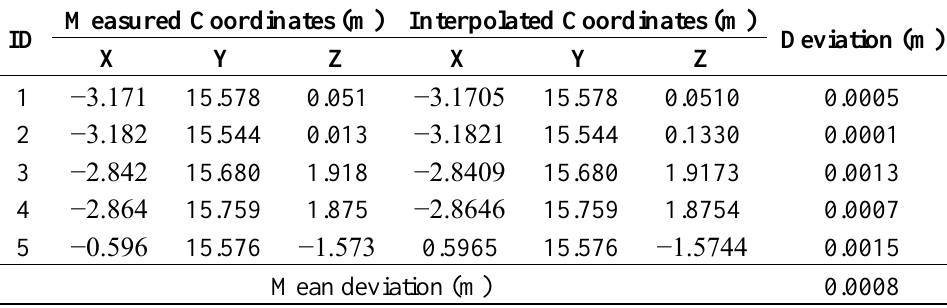
Table 4. Accuracy of the cross-sectional point